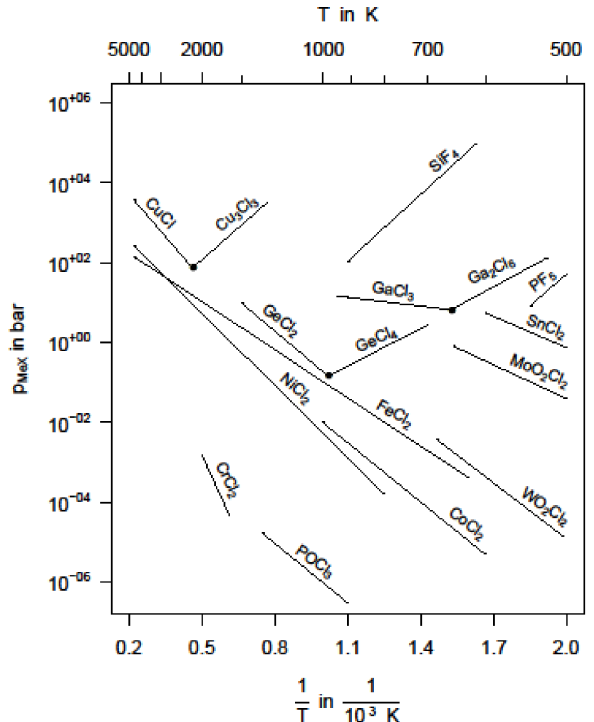
Figure 1. Diagram of reaction-conditioned pressure (p MeX ) at different temperatures (1/T) for selected MeX compounds in accordance with equilibrium reaction (1) (Schrön et al., 1988, Figures 1 and 2). (cid:129) dominance changes GeCl 2 /GeCl 4 ,GaCl 3 / Ga 2 Cl 6 , and CuCl/Cu 3 Cl 3 .